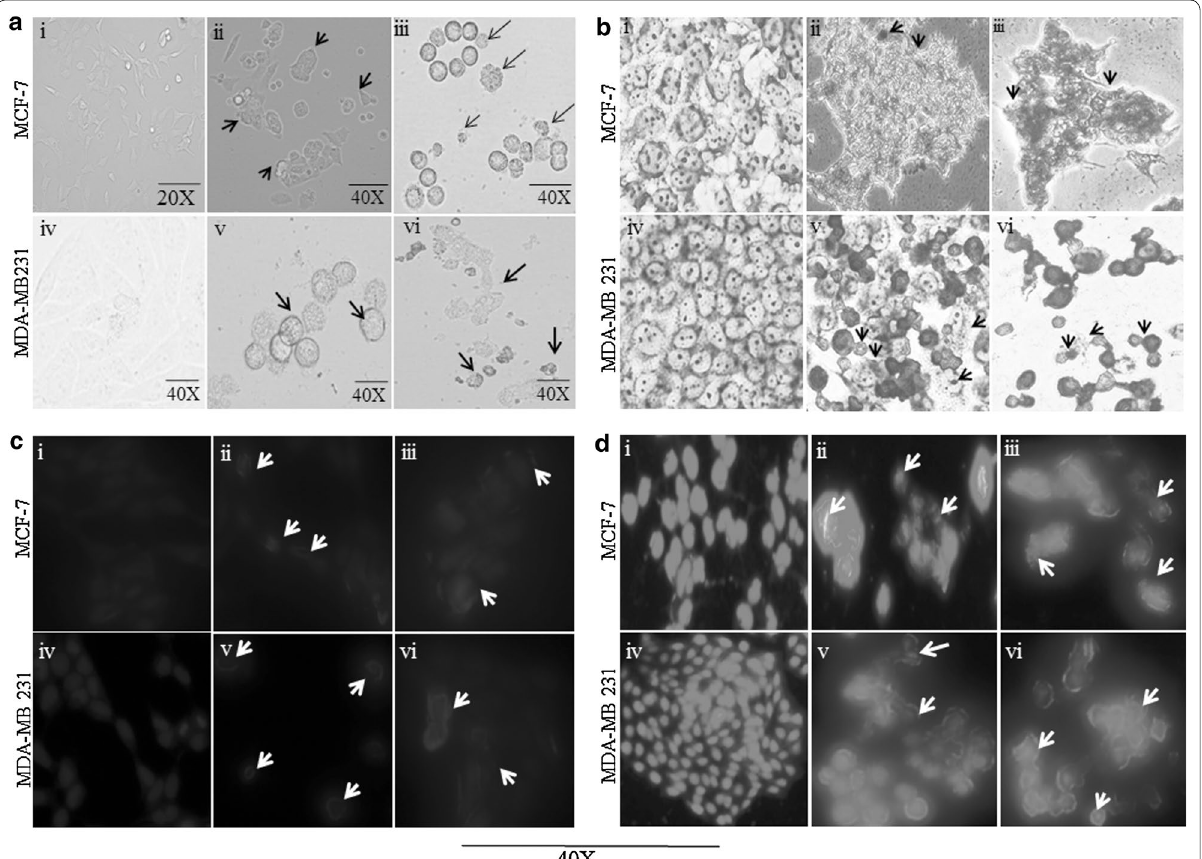
Fig. 2 Morphological study of apoptosis in MCF-7 and MDA-MB231 induced by BTB: a by phase contrast microscopy (optical): ( i , ii ) untreated cells, ( iii , iv ) treated with 50 μg/ml and ( v , vi ) 100 μg/ml for 48 h. b Stained with Giemsa: ( i , ii ) untreated cells, ( iii , iv ) treated cells with 50 µg/ml, ( v , vi ) treated with 100 µg/ml for 48 h. c Stained with Hoechst 33342: ( i , ii ) treated with 50 µg/ml and ( iii , iv ) 100 µg/ml for 48 h. d Stained with propidium iodide: ( i , ii ) untreated cells, ( iii , iv ) treated with 50 µg/ml and ( v , vi ) 100 µg/ml for 48 h as shown by